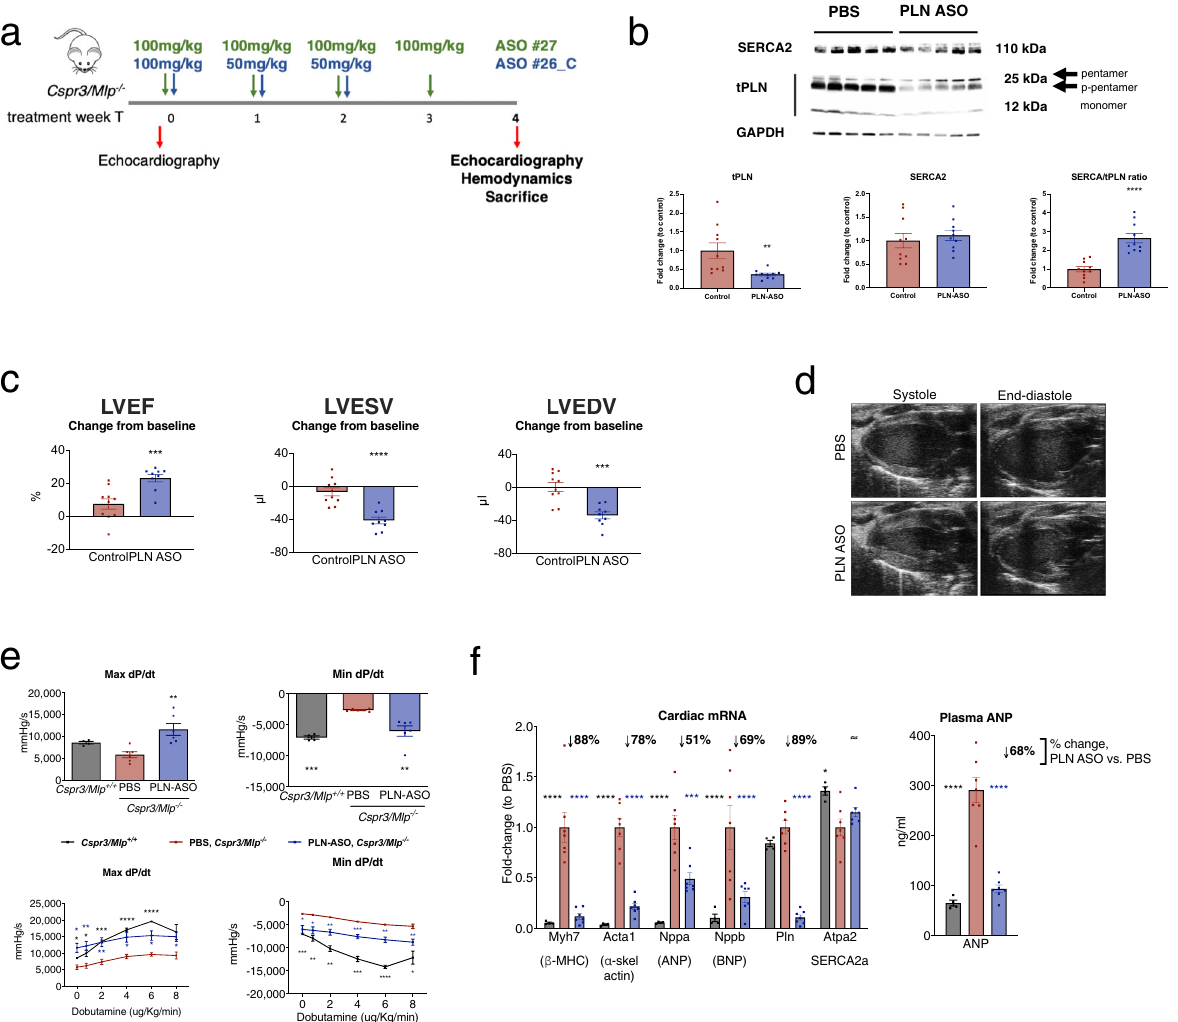
Fig. 3 Repeated subcutaneous injection of PLN ASO in Cspr3/Mlp − / − mice reverses signs and symptoms of heart failure. a Experimental design of the PLN-ASO Cspr3/Mlp − / − intervention study. Repeated studies were run with either PLN-ASO #27 (100 mg/kg on Days 0, 7, 14, and 21) or PLN-ASO #26_C (100 mg/kg on day 0, 50 mg/kg on days 7 and 14) (Supplementary Data 1). Echocardiography was performed at baseline (i.e., before treatment initiation), and at end of study (i.e., after 28 days of treatment), followed by termination of animals. Hemodynamic assessment was done between day 24 and 28. b Representative Western blot of LV protein lysates stained for PLN protein to detect the monomer and pentamer. Protein loading was normalized to GAPDH and total PLN protein were semi-quanti fi ed by calculating intensities relative to PBS treated control (PBS n = 10, PLN-ASO #26_C n = 10). c Individual echocardiography assessment and quanti fi cation of left ventricular ejection fraction (LVEF), left ventricular end-systolic volume (LVESV), and left ventricular end-diastolic volume (LVEDV) 28 days after treatment relative to baseline measurements. Cspr3/Mlp − / − mice with LVEF ≤ 45% at study initiation were included in analysis, combination of study 1* + 2^ (PLN-ASO #26_C treated n = 6* + 3^, PBS treated n = 7*, Control-ASO n = 1^, and no injection n = 2^ (Supplementary Data 1)). d Representative B-MODE echocardiography image of a Cspr3/Mlp − / − heart 28 days post treatment with PBS or PLN-ASO#26_C. e Hemodynamic assessment of the maximum/minimum fi rst derivative of LV pressure (Max dP/dt and Min dP/dt) was performed at 24 – 28 days following PLN-ASO_#27 or PBS treatment at baseline and upon increasing dobutamine doses of 0, 2, 4, 6, 8 µ g/kg/min in a study 3 ( n = 4 for Cspr3/Mlp + / + , n = 6 Cspr3/Mlp − / − PBS, and n = 6 Cspr3/Mlp − / − PLN-ASO_#27. For this study cohort Cspr3/Mlp − / − mice were selected based on high plasma ANP levels (>119 ng/ml) and randomized into treatment groups based on LVEF baseline levels (Supplementary Data 1)). f RT-PCR fold change analysis of transcriptional heart failure markers and plasma ANP ELISA in Cspr3/Mlp − / − PBS ( n = 7) and Cspr3/Mlp − / − PLN-ASO #27 ( n = 7) mice relative to non-HF Cspr3/Mlp + / + mice ( n = 4) after 4 weeks of treatment. Students ’ T test, one and two-way analysis of variance were used for analyses, with PBS/vehicle-treated animals as the reference group in multiple comparison analyses. Asterix denotes signi fi cance level based on two-sided P values compared to PBS/vehicle control with: * P value < 0.05; ** P value < 0.01; *** P value < 0.001; **** P value < 0.0001. Single values are depicted, and error bars represent standard error of the mean (SEM). ASO antisense oligonucleotide, ANP atrial natriuretic peptide. Source data are provided as a Source Data fi le.